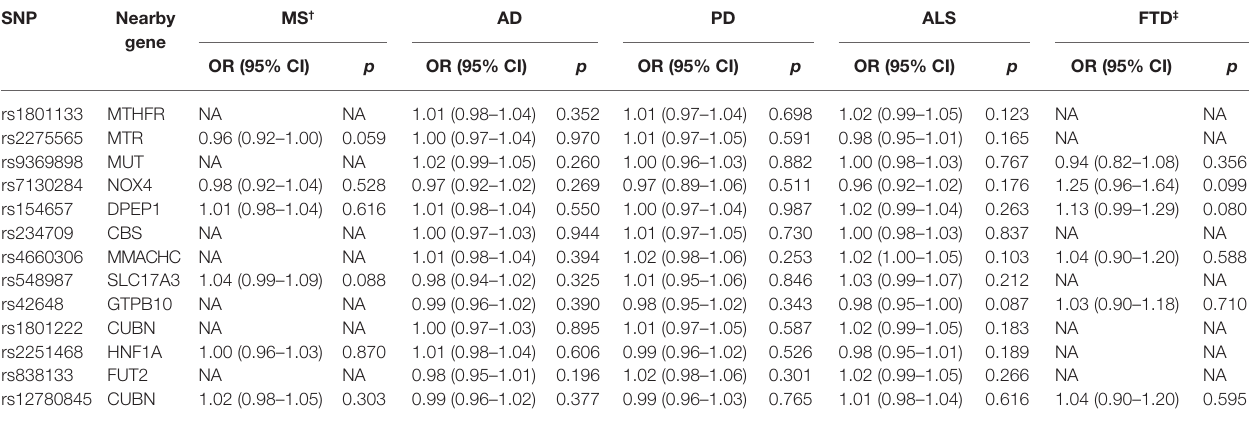
TABLE 2 | Main MR results of the effect of Hcy on neurodegenerative disease. SNP Nearby